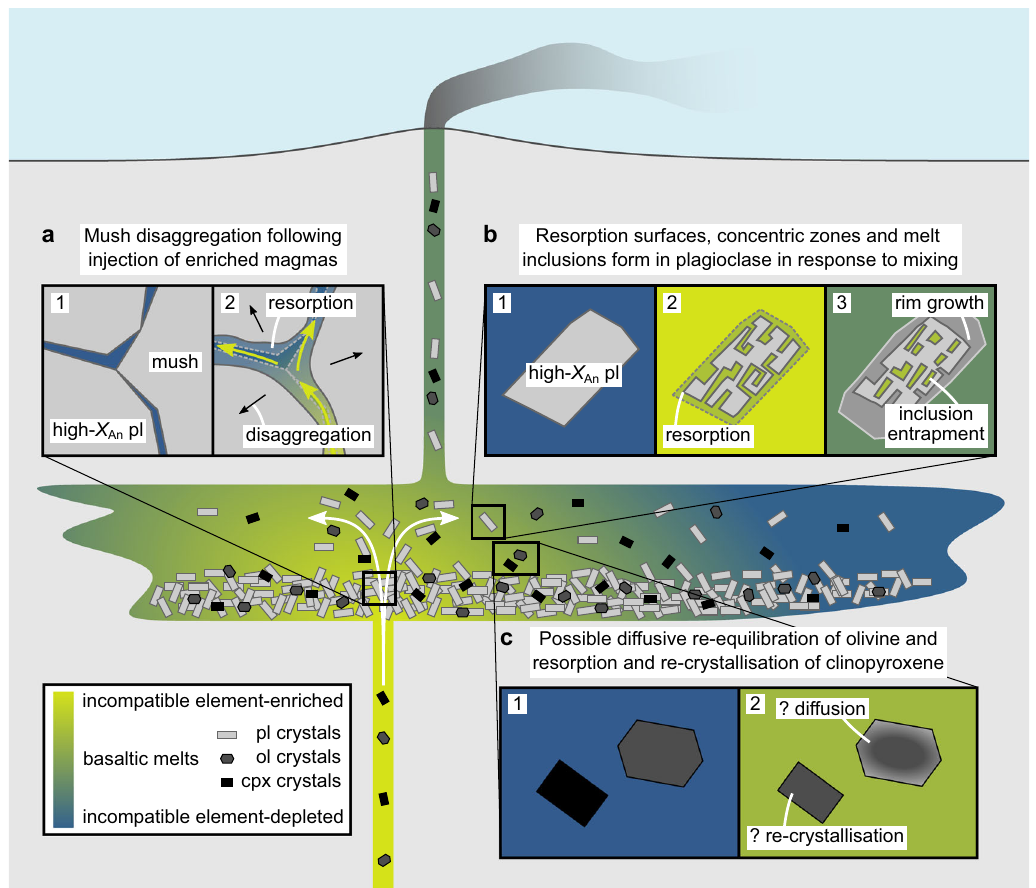
Fig. 10 Cartoon summarising how mixing-induced chemical disequilibrium creates and modi fi es basaltic crystal cargoes. Primitive and incompatible element-depleted magmas crystallise high-anorthite [high- X An , where X An = Ca/(Ca + Na + K) on a molar basis] plagioclase (pl) alongside olivine (ol) and clinopyroxene (cpx) during storage in the crust 7,70 . Even under isothermal conditions, recharge by incompatible element-enriched and plagioclase- undersaturated primitive magmas can trigger changes in the crystalline portions of incompatible element-depleted and plagioclase-saturated magma reservoirs. a The in fi ltration of plagioclase-dominated mushes by plagioclase-undersaturated liquids may trigger mush disaggregation by driving resorption within interstices and along grain boundaries, as indicated by chemical and isotopic disequilibria between some basaltic melts and their cargoes of high- X An plagioclase crystals 22,65 . b The transfer of high- X An plagioclase crystals between variably incompatible element-enriched magmas that are also variably saturated in plagioclase produces resorption surfaces, concentric zoning, overgrowth rims and melt inclusions 19,20,23 . c Olivine and clinopyroxene crystals may re-equilibrate, and resorb and re-crystallise, respectively, in response to isothermal mixing of variably incompatible element-enriched magmas with different major element